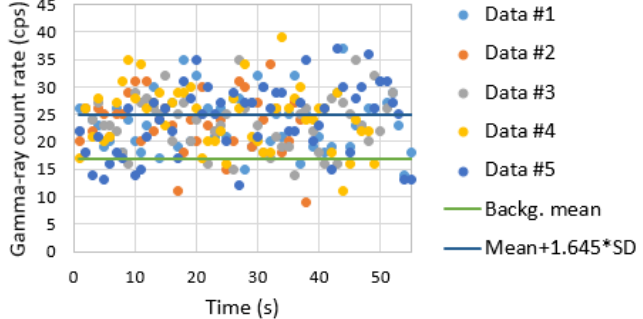
Figure 25. EJ-200 scintillator gamma-ray count rate (cps) measurements performed along the con- tainer length with detection system coupled with the drone considering the Troxler equipment oriented 90 ◦ (shielded 215 MBq 137 Cs source—safe position) positioned at the center of the shipping container. Drone trajectory was performed at half the container